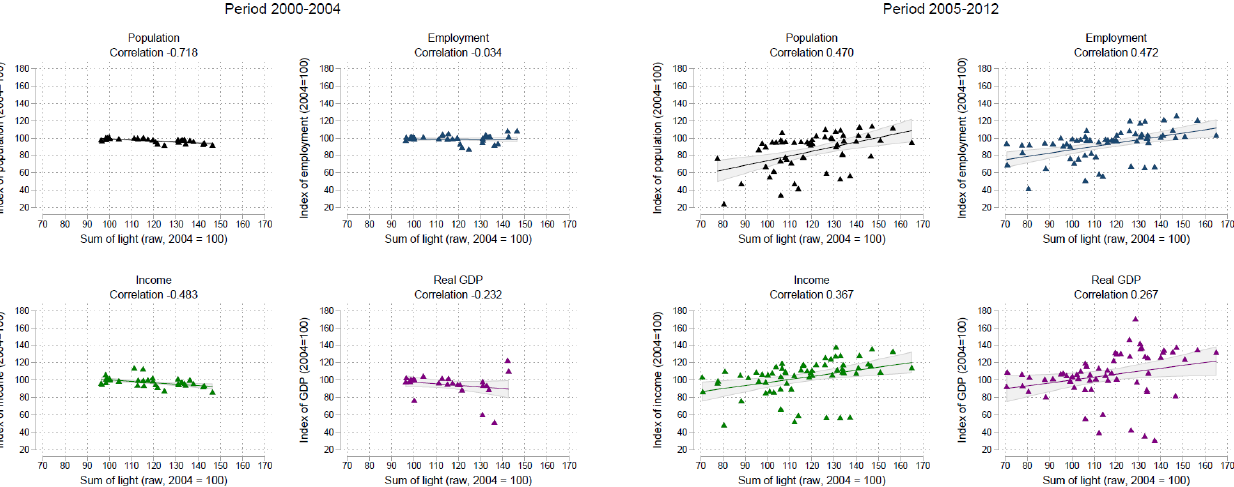
Figure A9. Indexed economic indicators and total sum of light for the eight affected counties before Katrina (raw data). Correlations of economic indicators and night lights (raw data). Raw night light data, indexed to 2004 = 100. Right panel: population data are for 2006–2012